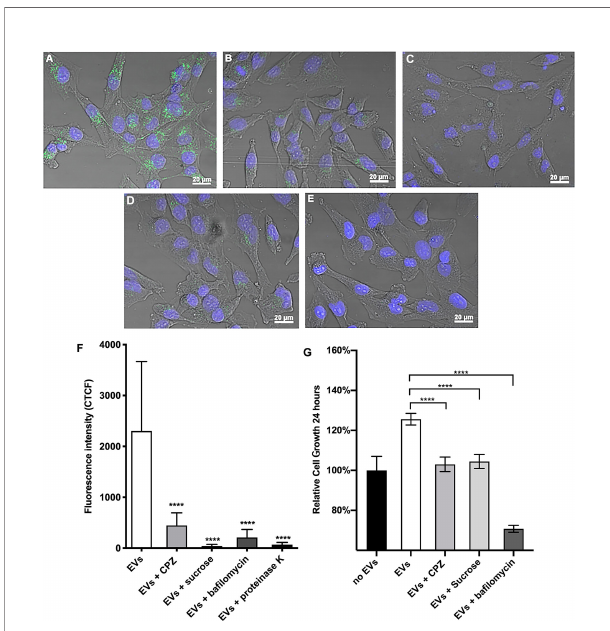
FIGURE 3 | Chemical inhibition of endocytosis pathways blocks the uptake of O. viverrini 120k extracellular vesicles and reduces proliferation of cholangiocytes. H69 human cholangiocytes were cultured with PKH67- labeled O. viverrini 120k extracellular vesicles (EVs) for 2 hours in the presence of PBS control (A) , chlorpromazine (CPZ) (B) , sucrose (C) or ba fi lomycin A1 (D) . PKH67-labeled 120k EVs were also pre-treated with proteinase K prior to co-culture with H69 cholangiocytes (E) . Corrected total cell fl uorescence was quanti fi ed by imageJ (F) . Cholangiocyte proliferation induced by 120k EVs in the presence or absence of endocytosis inhibitors was measured in real time using an xCELLigence system (G) . Thirty cells were counted form 3 random microscope fi elds for each sample in 2 independent experiments. Values are mean ± SD. The corresponding p- values ( ****P < 0.0001) were performed by one-way ANOVA with Tukey- Kramer post-hoc multiple comparison